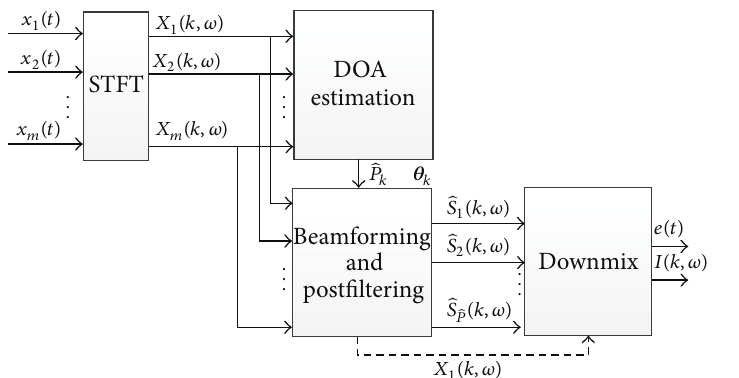
Figure 1: Analysis stage of the proposed method.